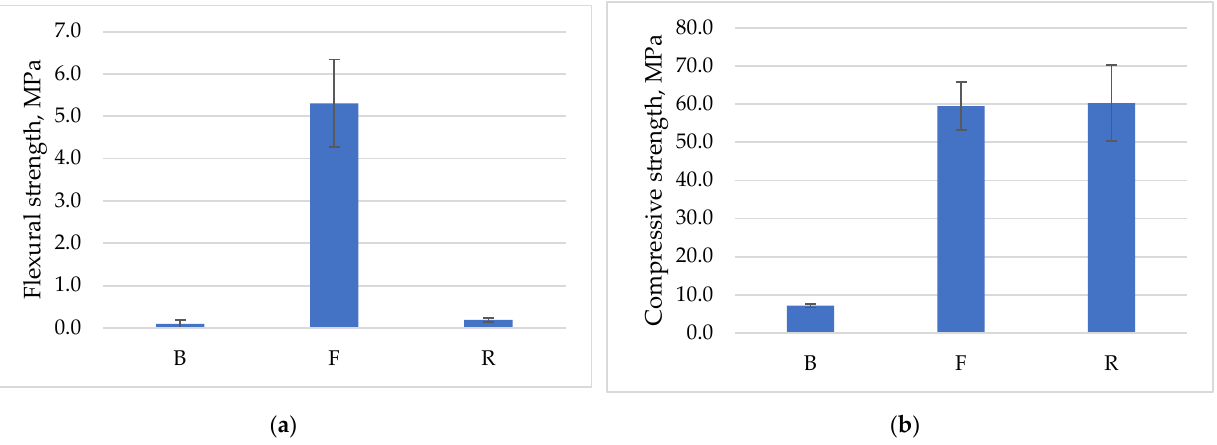
Figure 5. Results of mechanical properties tests: ( a ) Flexural strength; ( b ) Compressive strength.